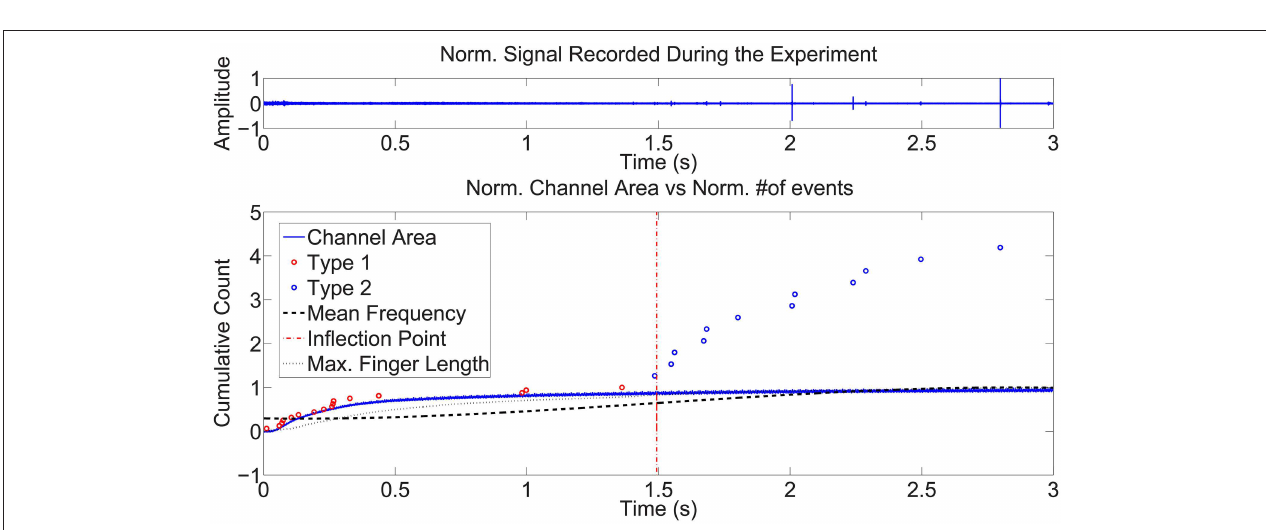
FIGURE 9 | Top: Signal recorded during the experiment. Bottom: Blue curve shows dark pixel counting over the image to compare compacted area with the number of different acoustic events occurred. Circles represent cumulative number of events normalized with maximum number of Type 1 events (i.e., 17 events). Cumulative number of Type 1 events (red points) are fitting well to the normalized channel area with time presented in the lower plot. First Type 2 (blue) event occurs very close to the inflection point of the mean frequency curve. Type 2 events are very impulsive and noticeable in the top panel as